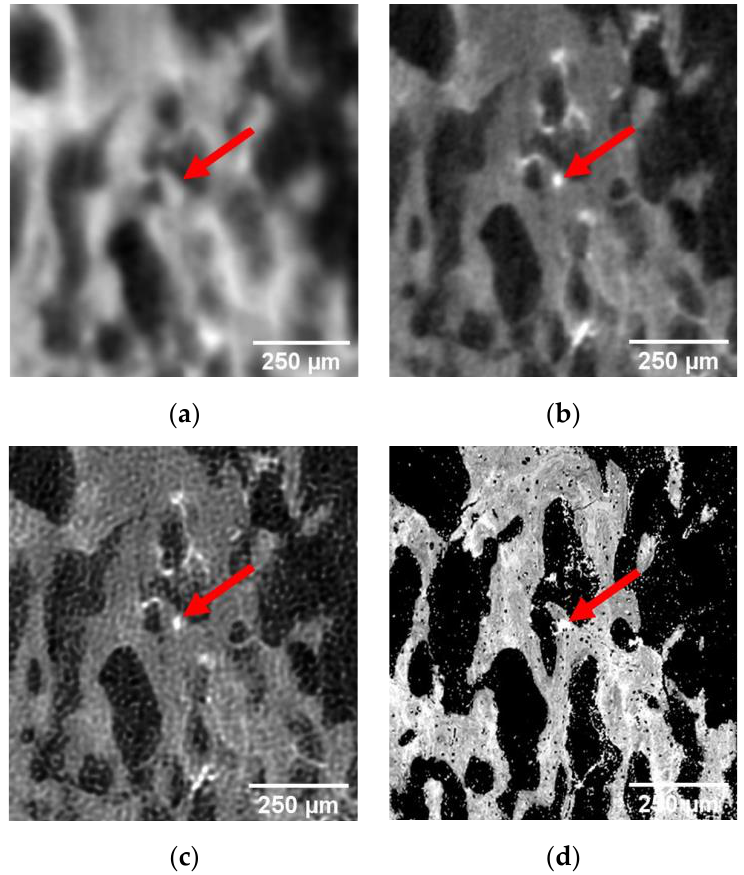
Figure 3. BaSO 4 visualization of microdamage in trabecular bone of a healthy rat L1 vertebra with four imaging modalities. ( a ) baseline µCT; ( b ) enhanced µCT; ( c ) enhanced µCT with a deblurring algorithm applied post-acquisition; ( d ) BSE imaging. The red arrow identified matching BaSO 4 stained structures in all images.